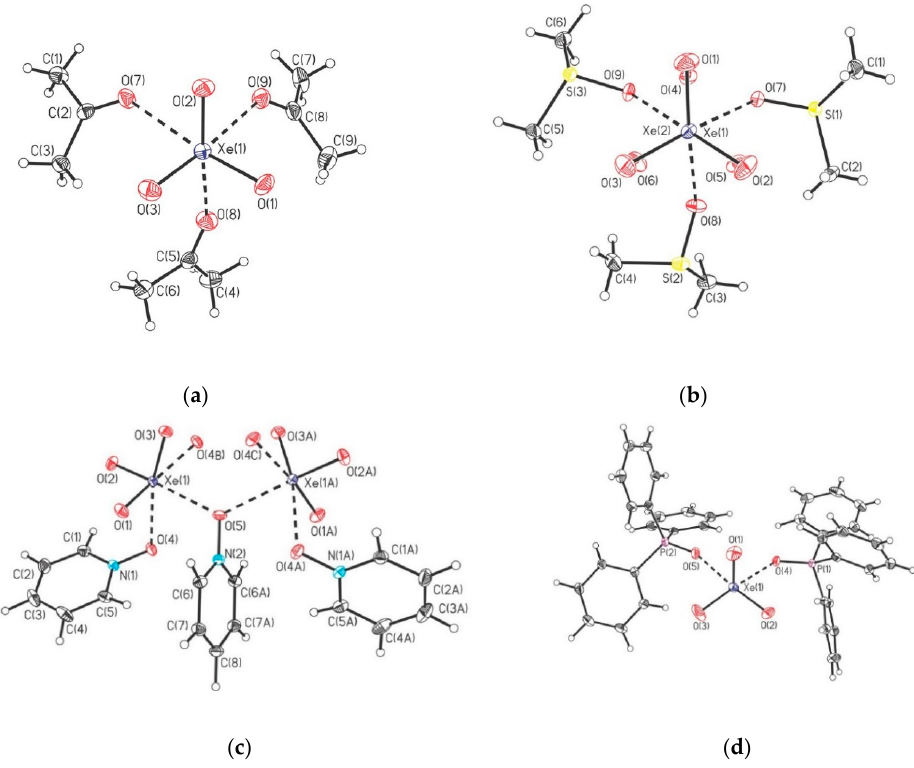
Figure 16. The structural units in the crystal structures of ( a ) [(CH 3 ) 2 CO] 3 XeO 3 ; ( b ) [(CH 3 ) 2 SO] 3 (XeO 3 ) 2 ; ( c ) (C 5 H 5 NO) 3 (XeO 3 ) 2 ; ( d ) [(C 6 H 5 ) 3 PO] 2 XeO 3 . Copyright (2019) Wiley. Used with permission from Ref. [42].